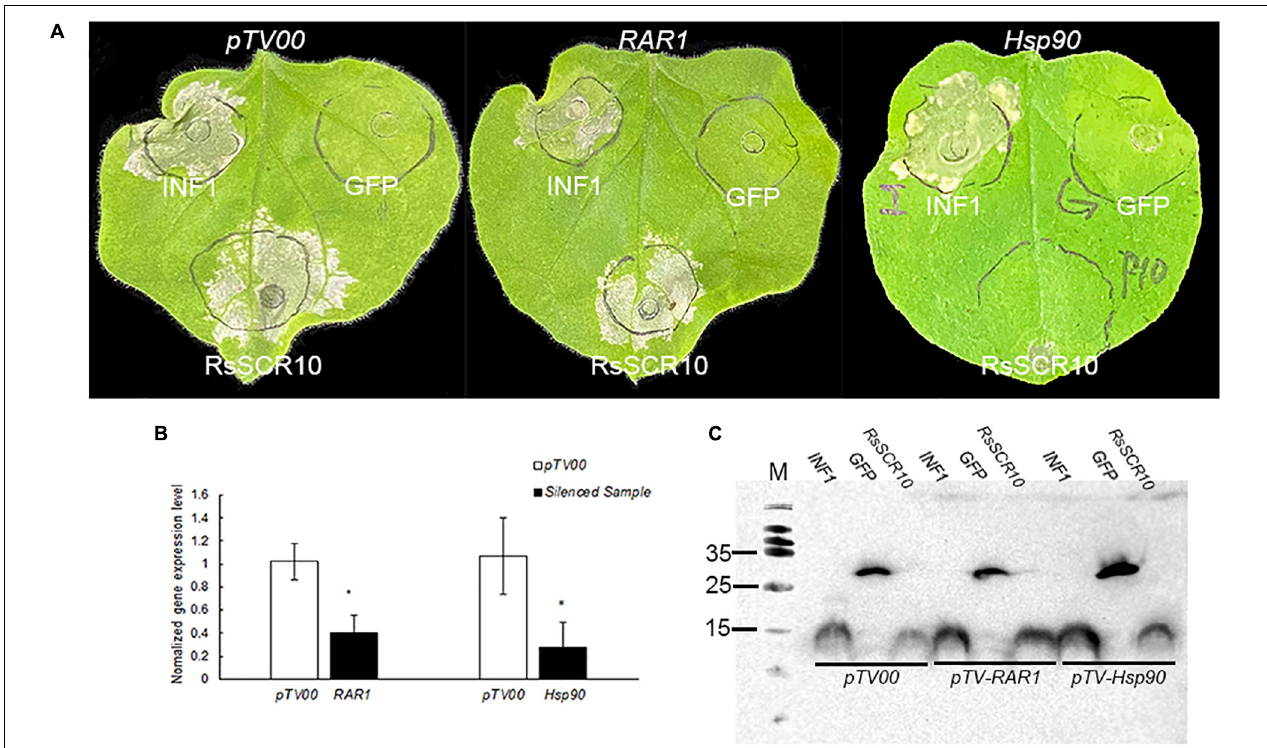
FIGURE 6 | Hsp90 was required for RsSCR10-induced cell death in N. benthamiana . (A) RsSCR10 was transiently expressed in N. benthamiana leaves silenced for pTV00 (control), Hsp90, or RAR1. GFP and INF1 were control proteins. Typical symptoms were photographed 5 days postinfiltration. (B) Transcription of genes in silenced N. benthamiana measured by qRT-PCR. Error bars represent standard errors from three biological replicates. *Statistical significance at 5% level (Student’s t -test). (C) Expression of proteins in infiltrated leaves detected by Western blotting. All data are means from three independent experiments.